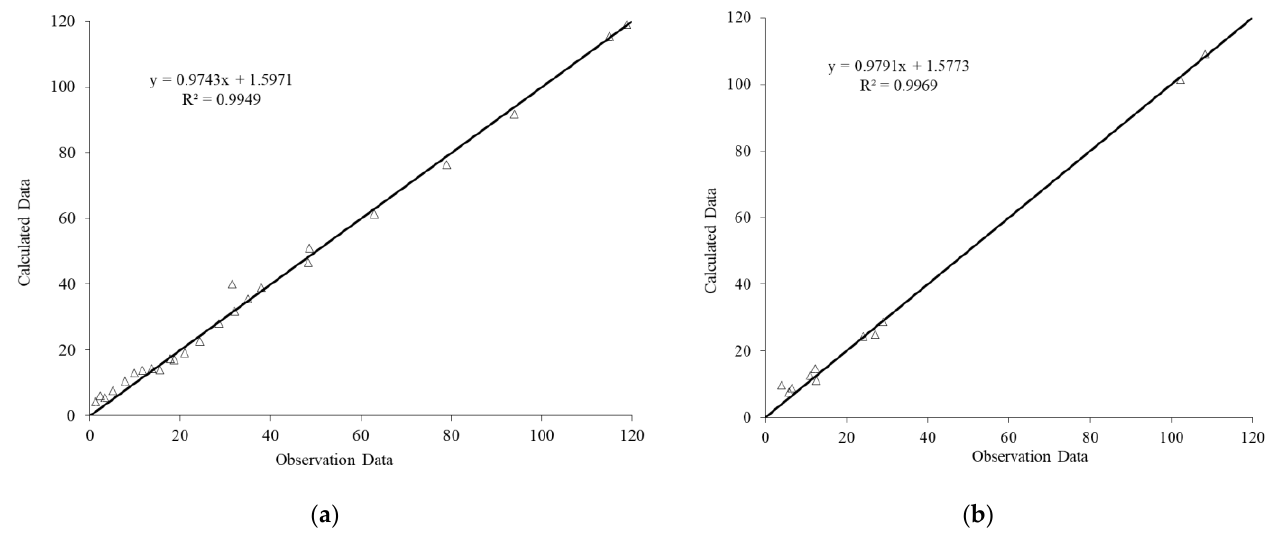
Figure 19. Predicted versus Experimental values of healing efficiency output using ( a ) training data, ( b ) testing data.